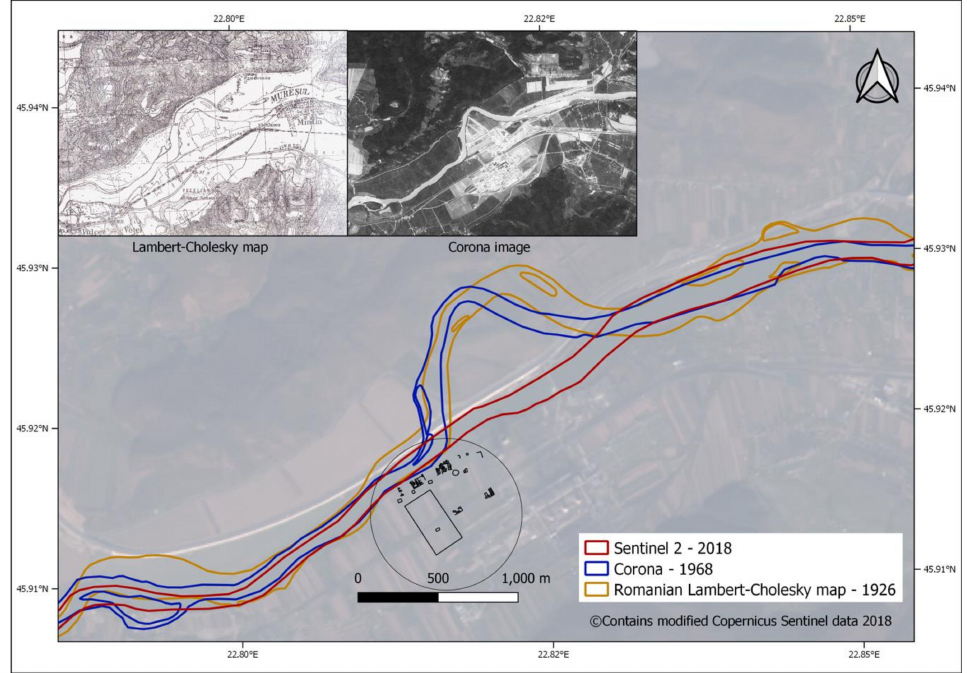
Figure 11. Micia archaeological site—the evolution of the Mures (background image: Sentinel–2, RGB combination: B4–B3–B2 natural colours, 10 m spatial